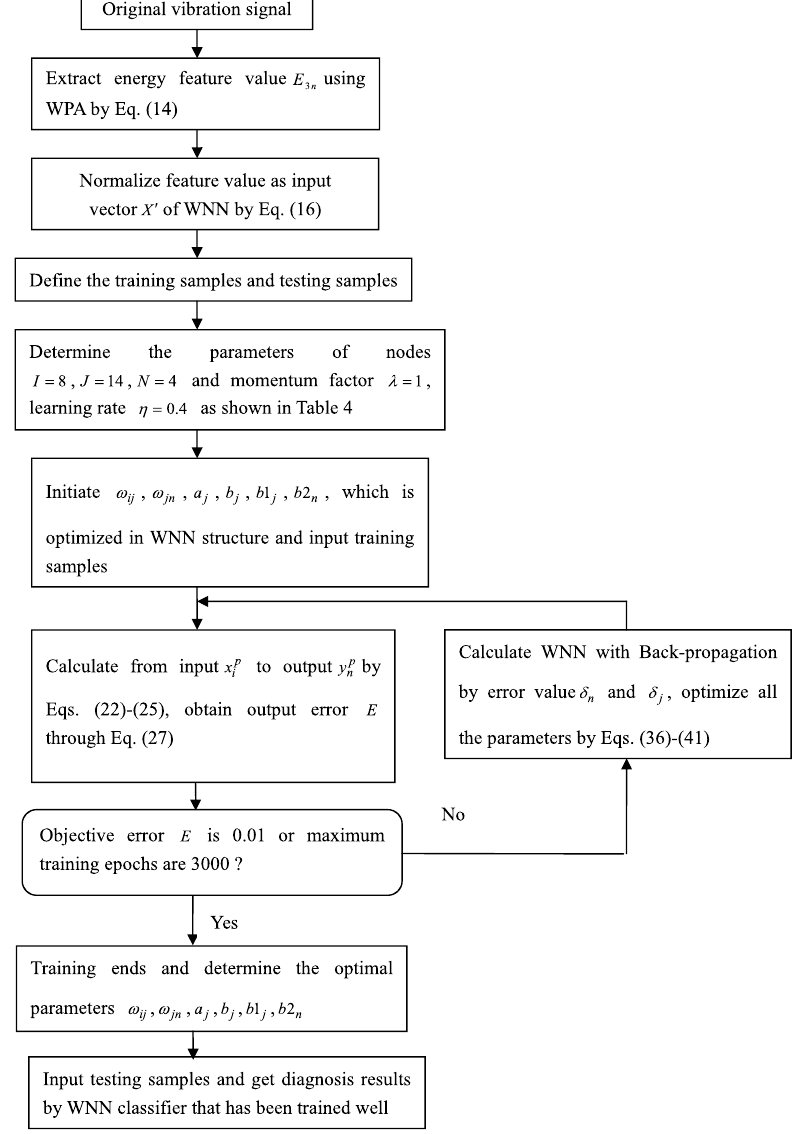
Fig. 3. The algorithm base on WPA for feature extraction and parameter optimization of WNN with BP